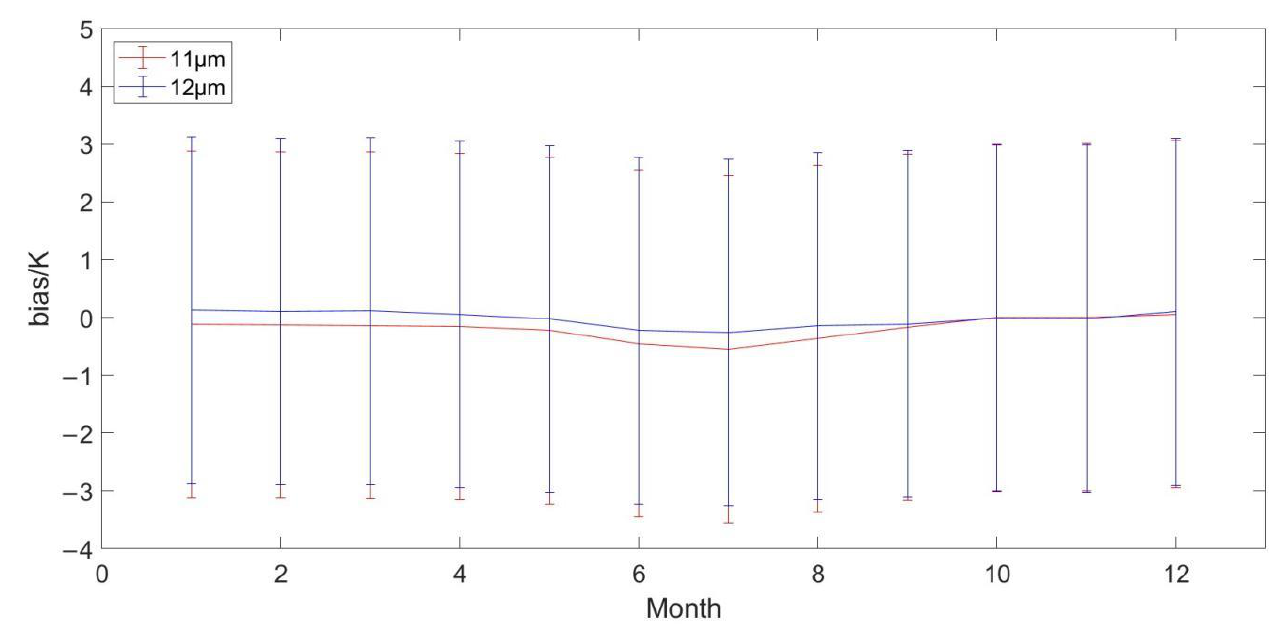
Figure 9. Mean bias and Std of the thermal infrared channels 11 μm and 12 μm T b data for MERSI and MODIS.